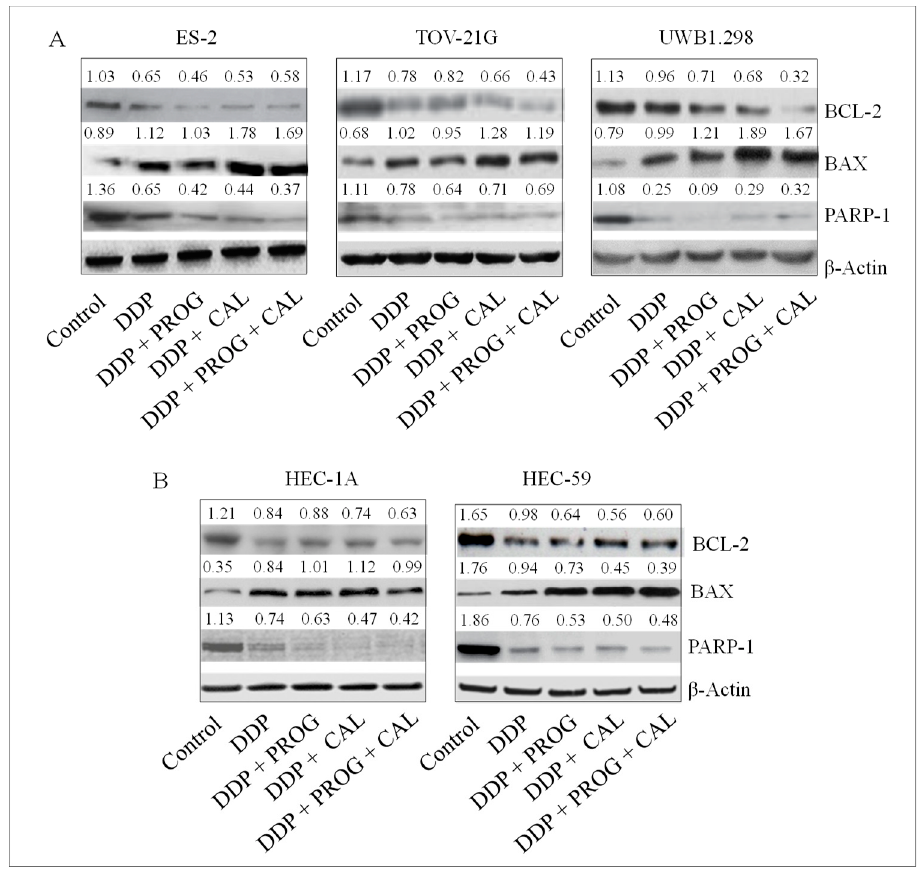
Figure 3. Progesterone-calcitriol combination enhanced DDP induced apoptosis modulating apoptotic proteins. The ovarian ( A ) and endometrial ( B ) cancer cells were treated with DDP (6 µ M) and either with progesterone (20 µ M), calcitriol (30 nM), or the combination of the two for 76 h. Lysates from treated and control cells were subjected to Western blotting for the assessment of apoptotic proteins. β -actin was used as a loading control. The values above the bands represent the relative density of the bands normalized to β -actin.